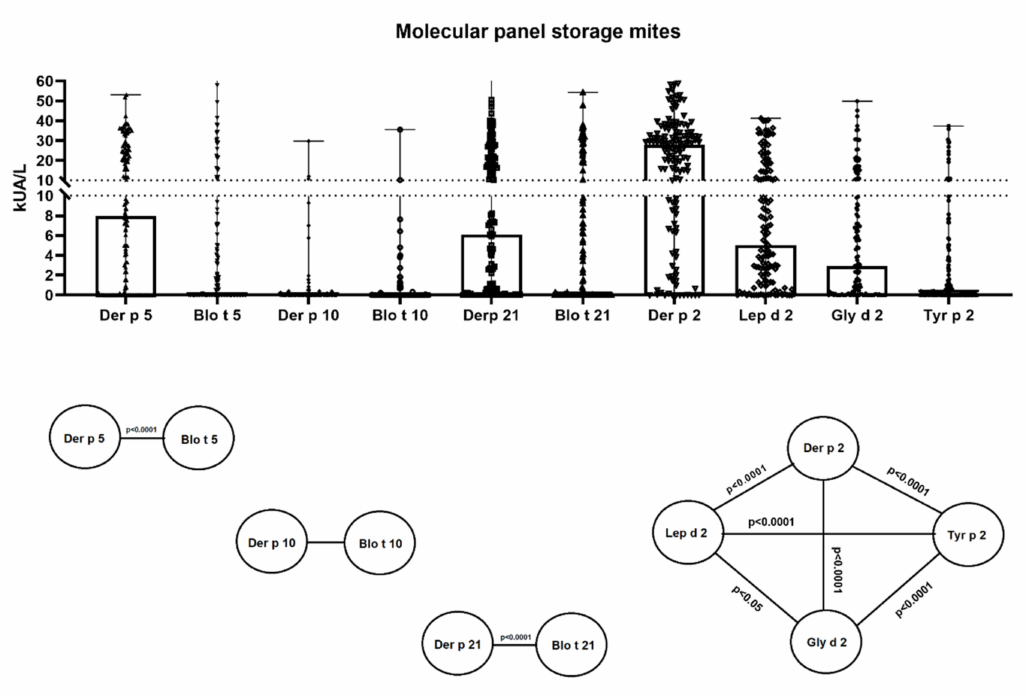
Figure 2. Specific IgE serodominance in a comprehensive panel of molecular allergens to Der- matophagoides pteronyssinus, Blomia tropicalis, Lepidoglyphus destructor, Glyciphagus domesticus and Tyrophagus putrescentiae in 133 asthmatic subjects. Statistical differences ( p < 0.001) among mite allergens from groups 2, 5 and 21 are